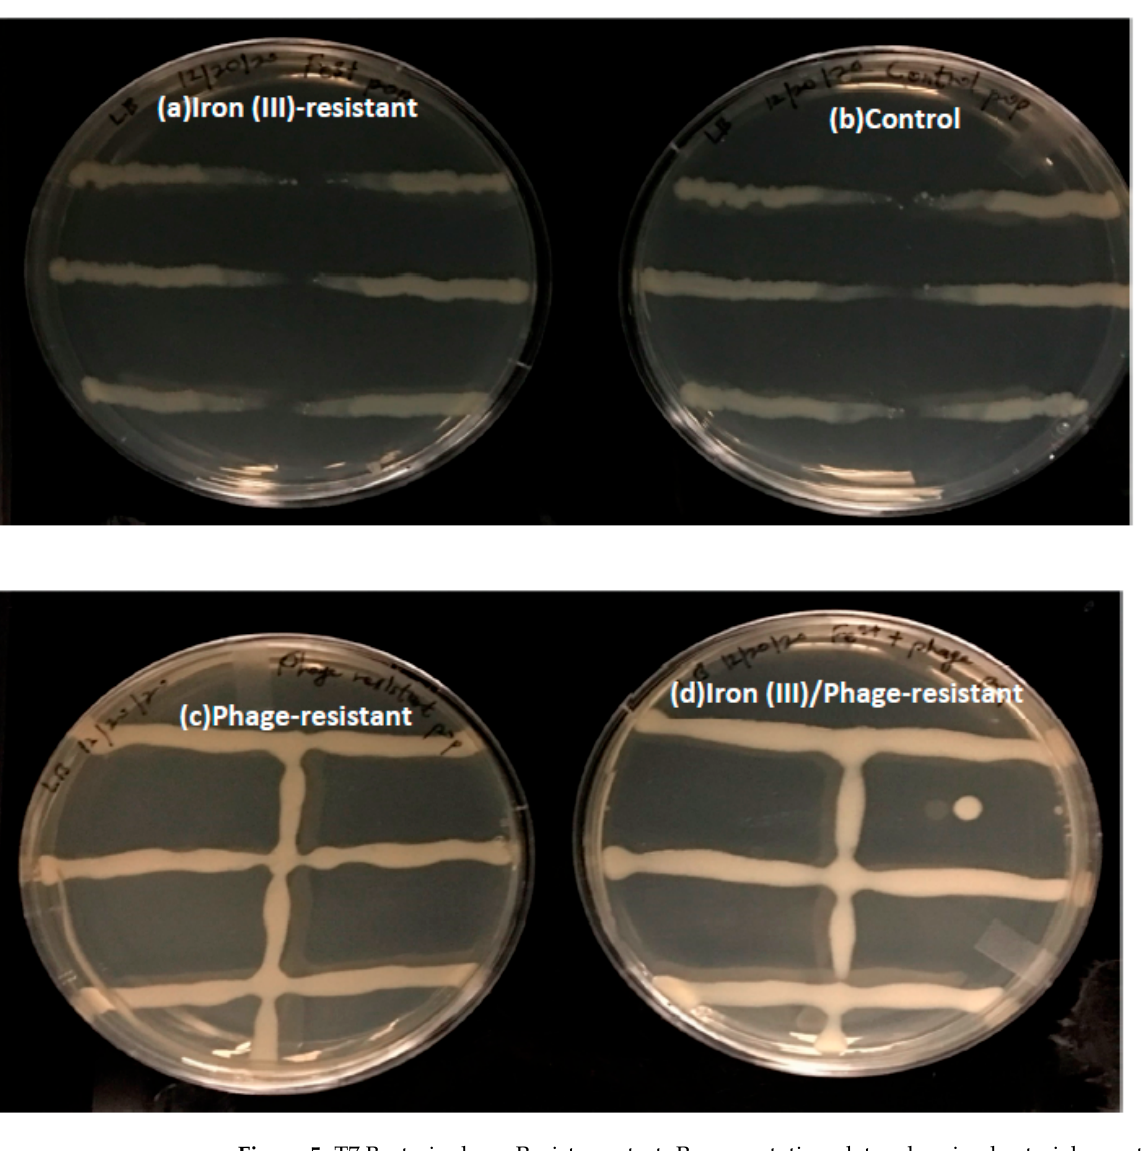
Figure 5. T7 Bacteriophage Resistance test. Representative plates showing bacterial growth in the presence of T7 bacteriophage for ( a ) Iron (III)-resistant E. coli population, ( b ) Control population, ( c ) Phage-resistant population, and ( d ) Iron (III)/phage-resistant population. Plates are representative samples of 10 replicates. Absence of a vertical bacteria growth line on plates ( a , b ) was an indication that these populations were not resistant to T7 bacteriophage, while the presence of a vertical bacteria growth line on plates ( c , d ) was an indication that these two populations were resistant to T7 bacteriophage.